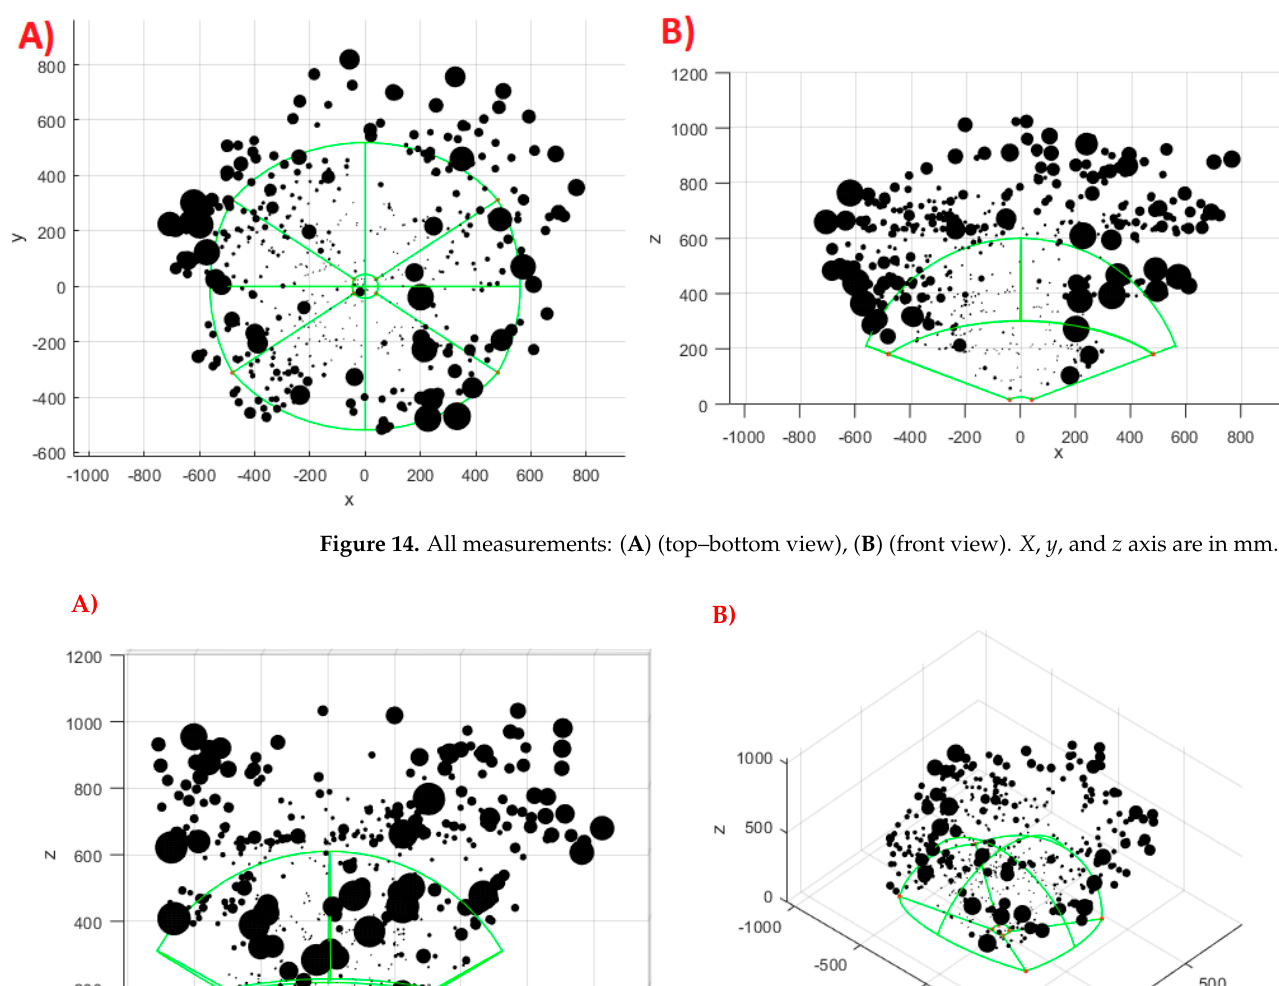
10 of 14 Figure 13. Up to 80 cm: overall view. X , y , and z axis are in mm. As is clear from the figures, in the range of 60 to 80 cm, all measurements are still within the proclaimed workspace. Furthermore, the tracking performs better than below 60 cm on the far right side (positive x axis) because both sides of the palm (thumb and pinky finger) are visible to the LMC in such a height.